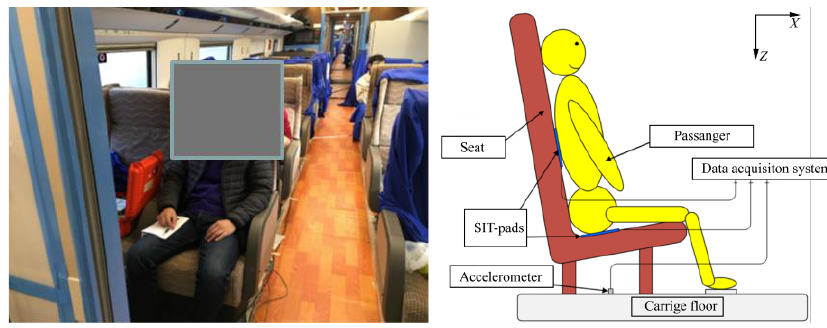
Figure 1 . On-site vibration test in a high-speed train . Figure 1. On-site vibration test in a high-speed